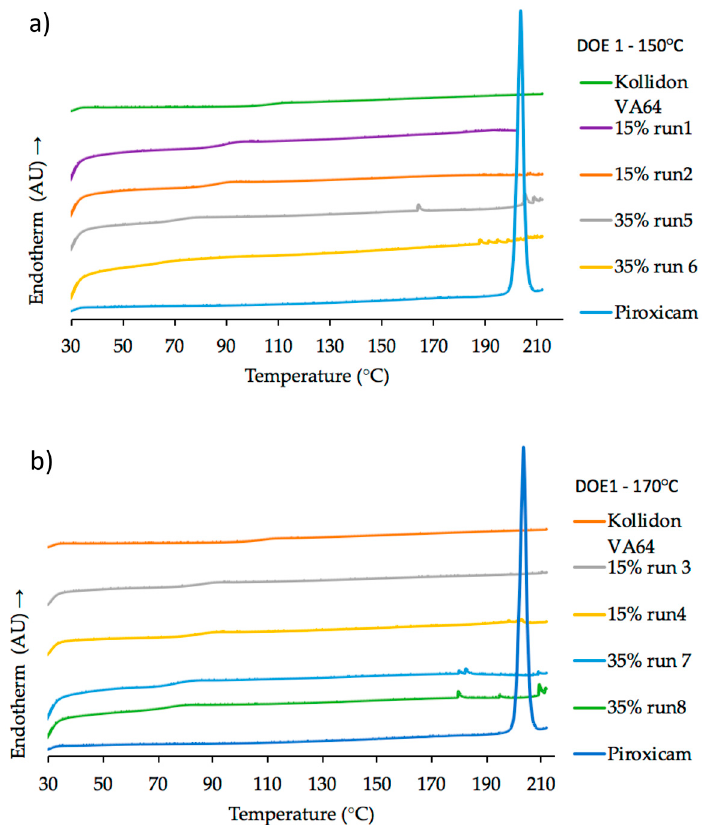
Figure 11. DSC heating curves (20 °C/min) of pure PRX, pure Kollidon ® VA64 as reference and samples from ( a ) DoE1 at 150 °C; ( b ) DoE1 at 170 °C.